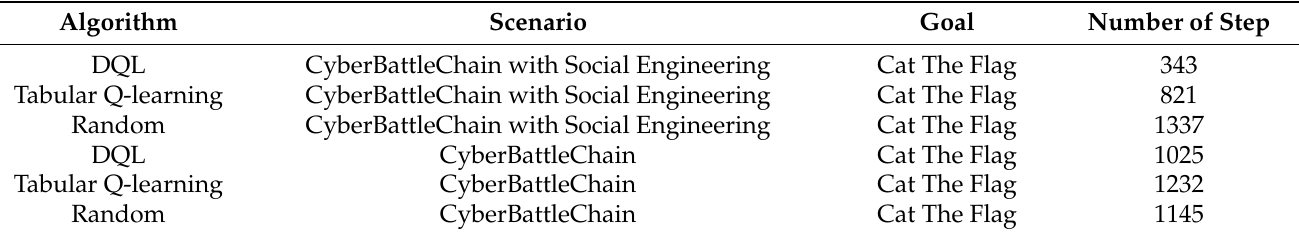
Table 4. Specific values of experimental results in Figure 12a.